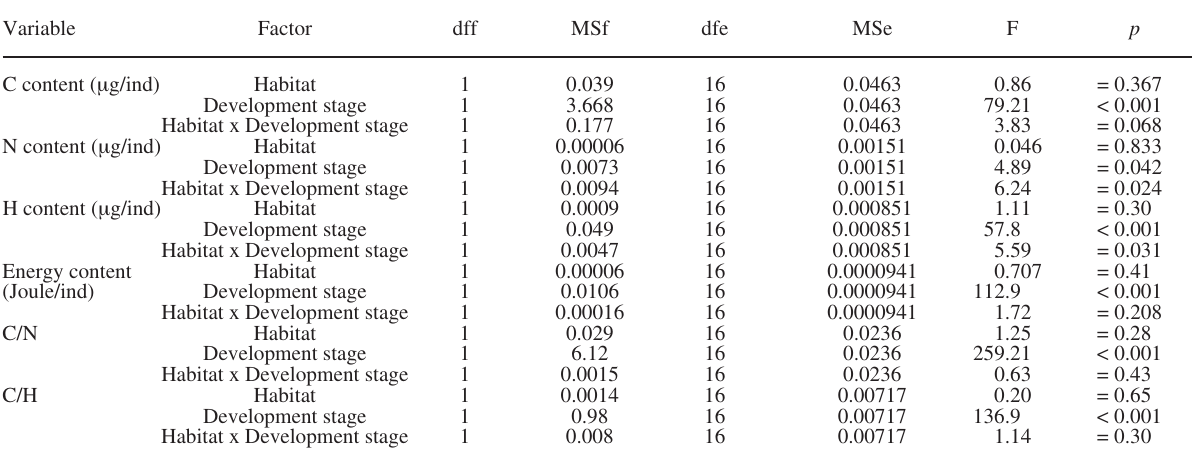
Table 7. – Neohelice granulata . Two-way anoVa evaluating differences in the proportions of embryonic contents of carbon (C%), nitrogen (n%), hydrogen (H%), dW-specific energy (J/mg dW), comparing different developmental stages (i, iii) and habitats (mudflats vs saltmarshes). Symbols as in Table